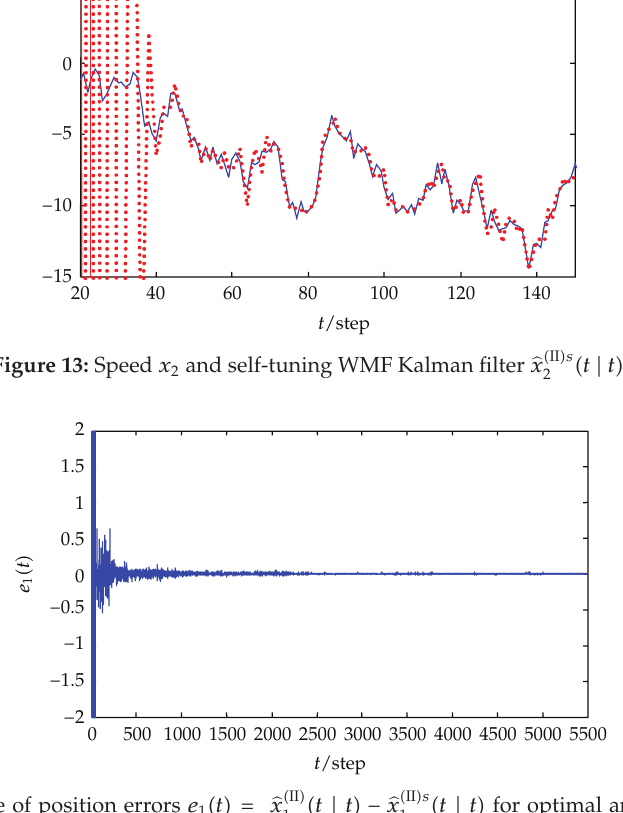
(cid:5) II (cid:6) (cid:5) t | t (cid:6) − (cid:11) x (cid:5) II (cid:6) s (cid:5) t | t (cid:6) for optimal and self-tuning WMF 1 1